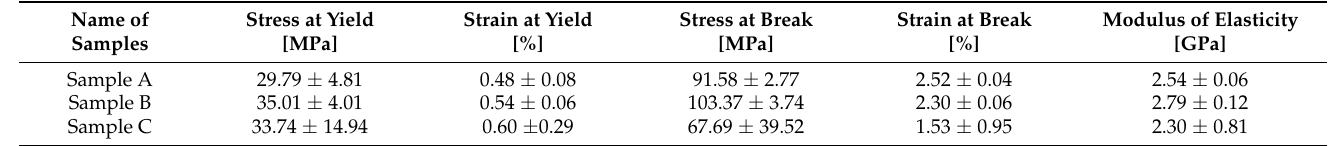
Table 4. Results of three-point bending tests of the amorphous-form